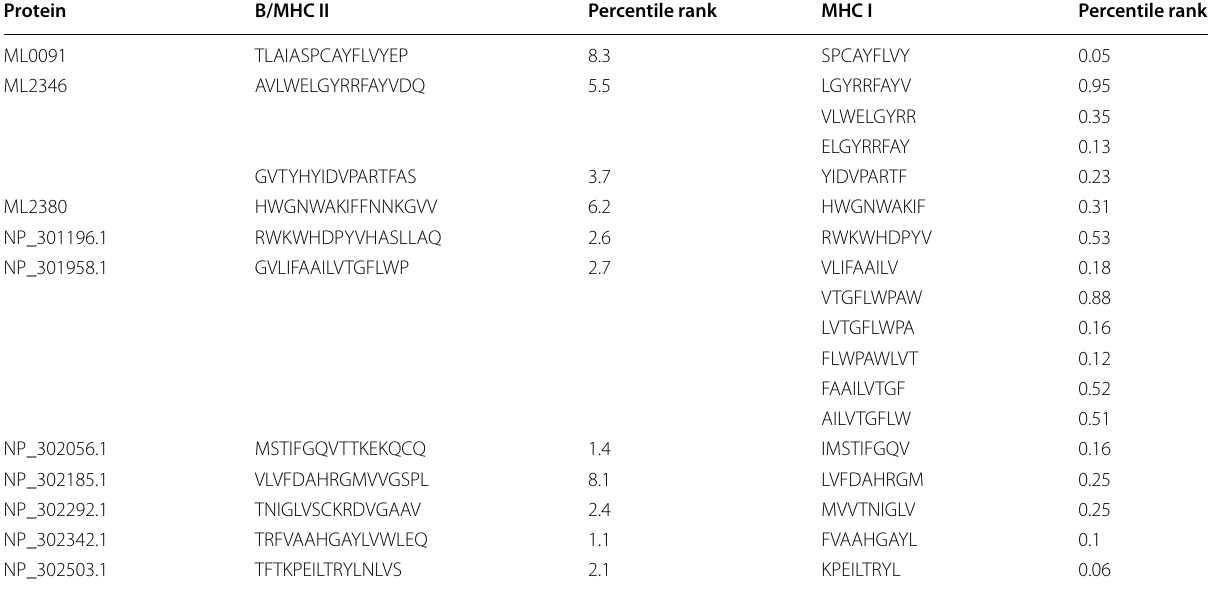
Table 1 Final list of the selected epitopes Protein B/MHC II